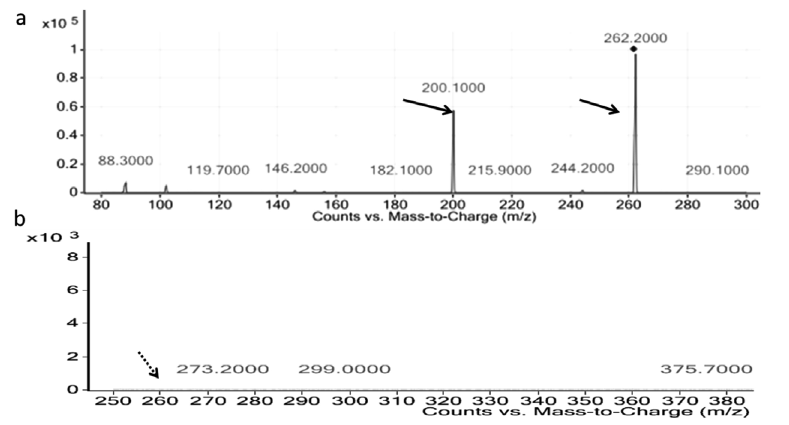
Fig. 4. LC-MS analysis of pyocyanin pigment of Pseudomonas aeruginosa a) Control b) grown with